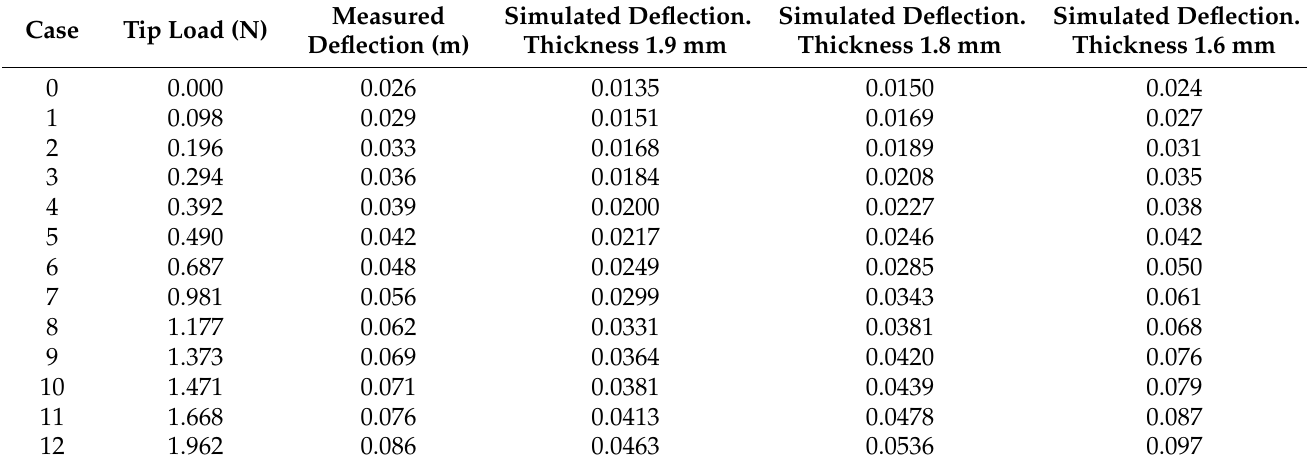
Table 5. Comparison between measured and predicted deflections for the wing spar